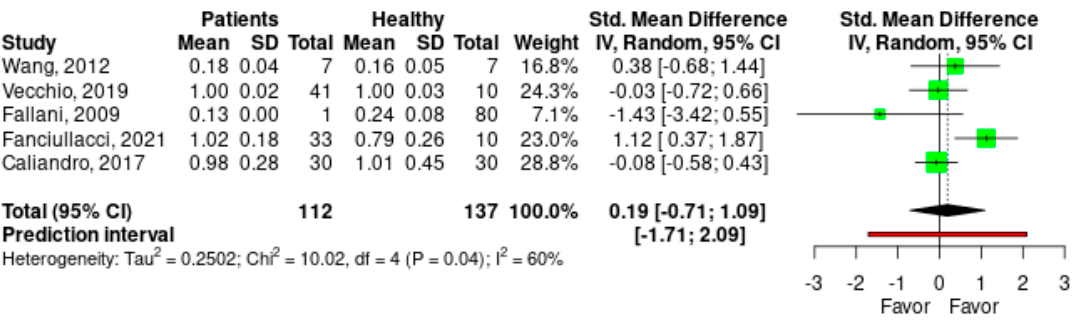
Figure 3. Meta-analysis forest plot for small-world index brain network measure on healthy subjects vs. stroke patients. SD: standard deviation; SMD: standardized mean difference; 95%CI: 95% confidence interval; Tau2: τ 2 between studies variance estimation; Chi 2 : Cochran Q test; df: degrees of freedom; I 2 : proportion of the variance in observed effect is due to variance in true effects rather than sampling error [7,8,10,12,13].